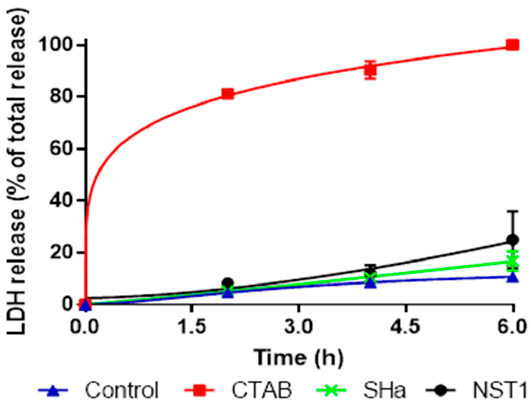
Figure 9. Lactate dehydrogenase (LDH) release from human gastric tissue exposed to temporin-SHa or NST1. Human gastric explants were treated with temporin-SHa (100 μ M) or NST1 (100 μ M) for 2, 4, 8 h before quantification of the release of LDH as explained in Materials and Methods. The LDH release caused by peptides was expressed as percentage of total release obtained with CTAB (300 μ M) used as positive control of tissue damages giving 100% release at 8 h. Results corresponding to means ± SD ( n = 3) were fitted using the Graph Pad Prism software.